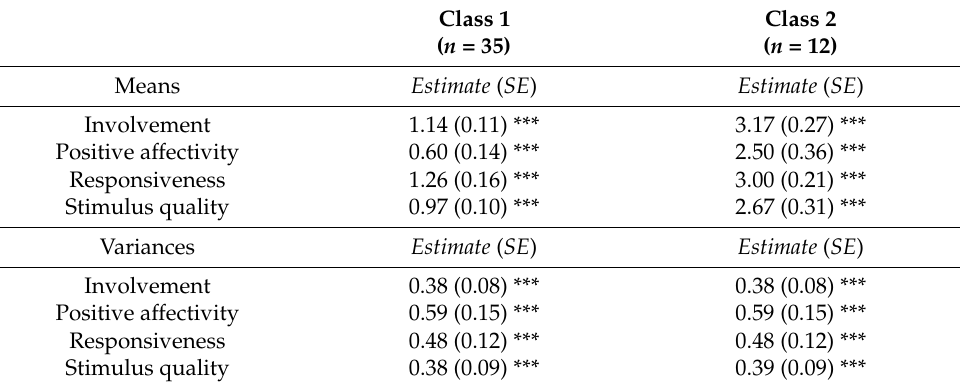
Figure 1. Latent profile analysis of the global rating dimensions. Table 4. Estimates and standard error for means and variances from the latent profile analysis.